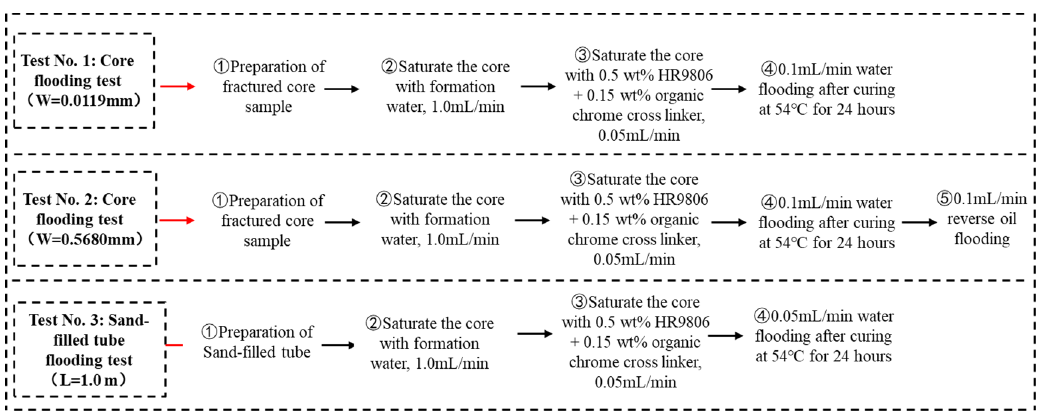
Figure 3. Flow test chart of core and sand-filled pipe.